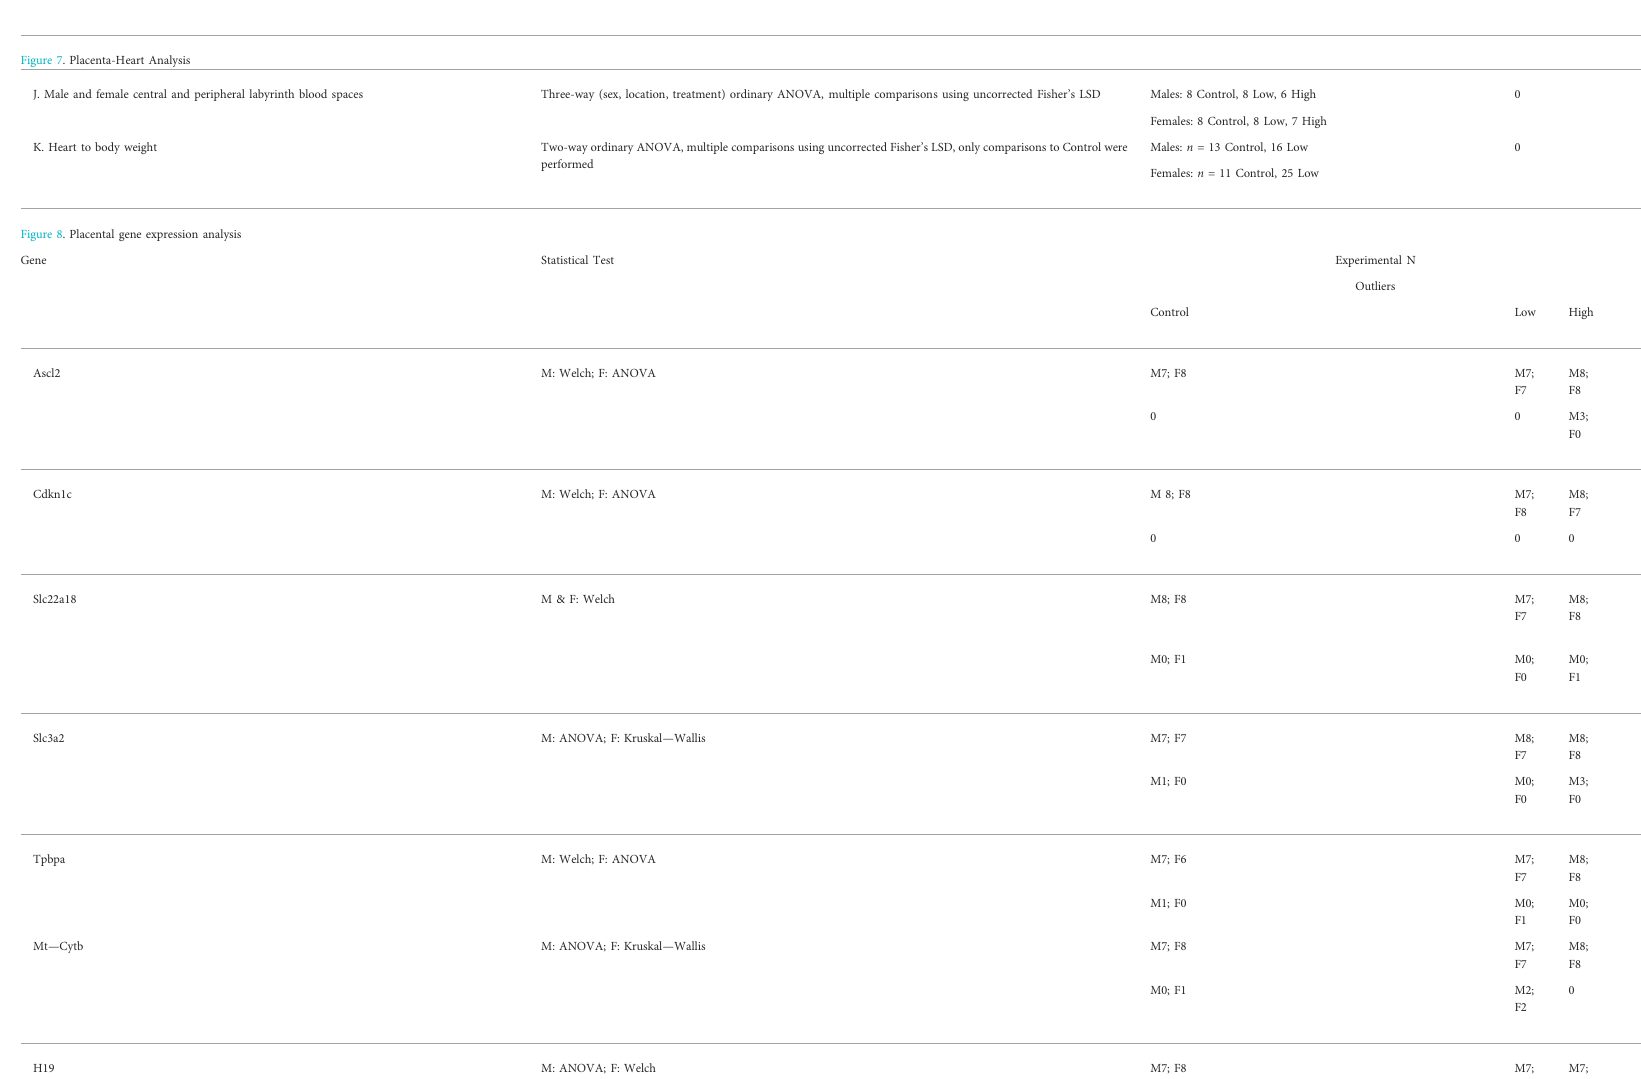
Figure 7. Placenta-Heart Analysis K. Heart to body weight Two-wayordinaryANOVA,multiplecomparisonsusinguncorrectedFisher ’ sLSD,onlycomparisonstoControlwere